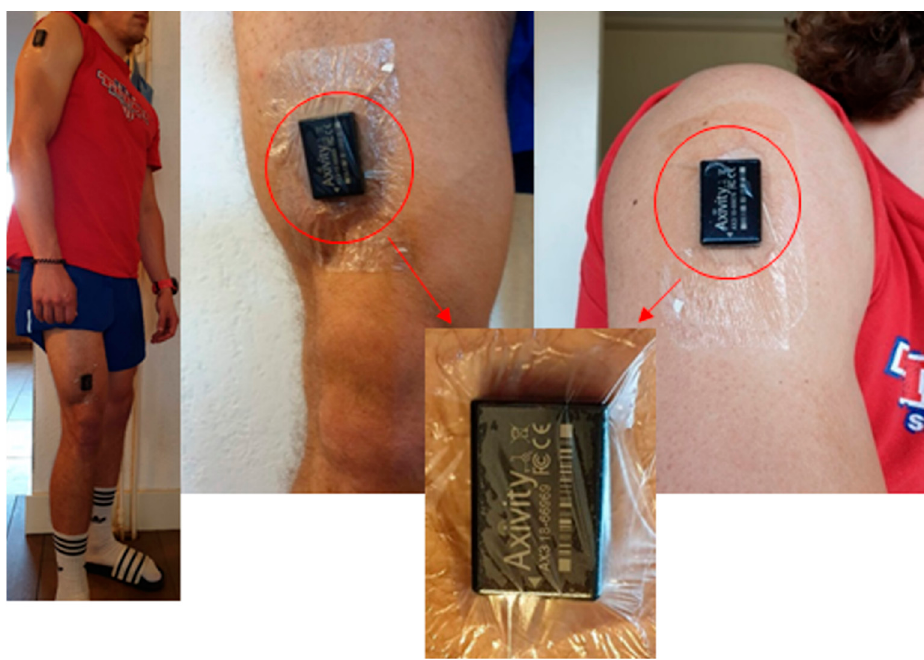
Figure 1. The AX3 accelerometers were placed lateroproximal on the right upper arm and anterodistal on the right upper leg. Permission was obtained for use of this photograph for